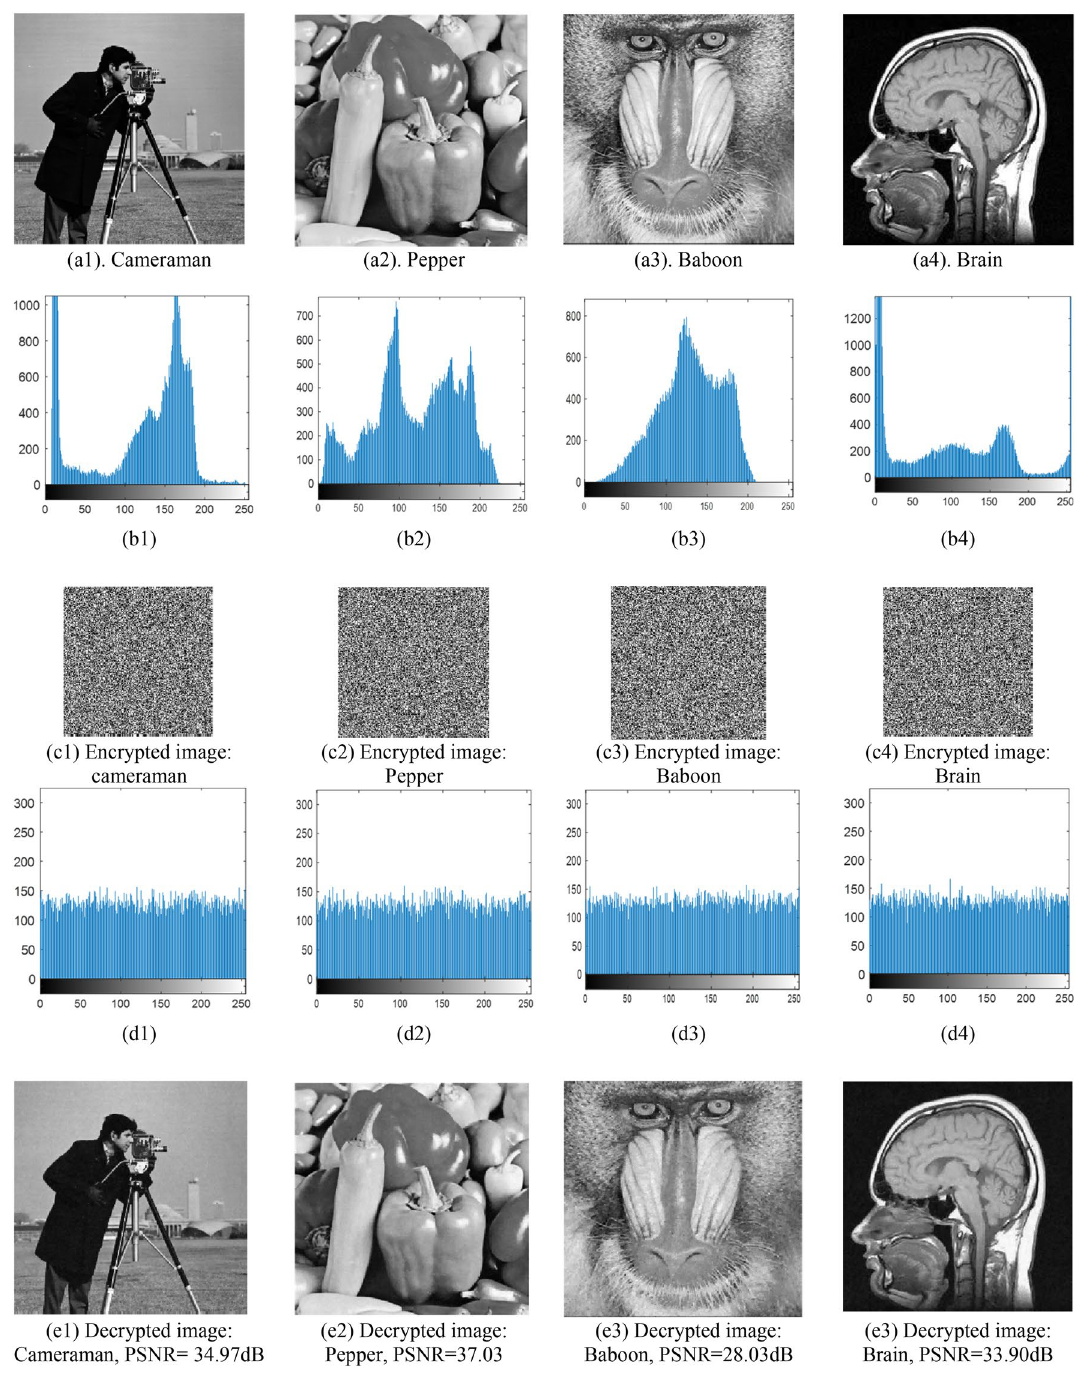
Figure 3. Experimental results: ( a1 – a4 ) original images; ( b1 – b4 ) the corresponding histograms of the original images; ( c1 – c4 ) the corresponding encrypted images of the original images; ( d1 – d4 ) the corresponding histograms of the encrypted images; ( e1 – e4 ) the corresponding decrypted images; Cameraman is used from the website https ://homep ages.cae.wisc.edu/~ece53 3/image s/; Pepper and Baboon are used from the website http:// sipi.usc.edu/datab ase/; Brain scan is used from the website https ://medic alxpr ess.com/news/2017-02-mri-brain -scans -adole scent -subst